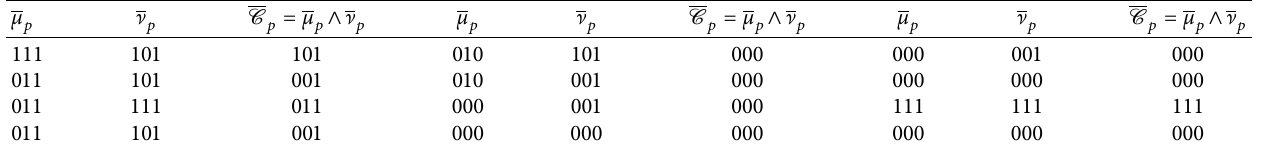
Table 1: Codewords over